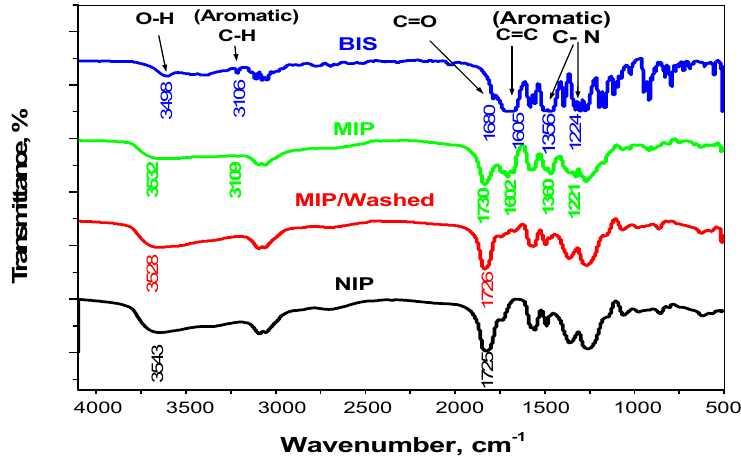
Figure 1. FT-IR spectra for bispyribac (BIS), bispyribac/MIP, MIP/washed and NIP beads.